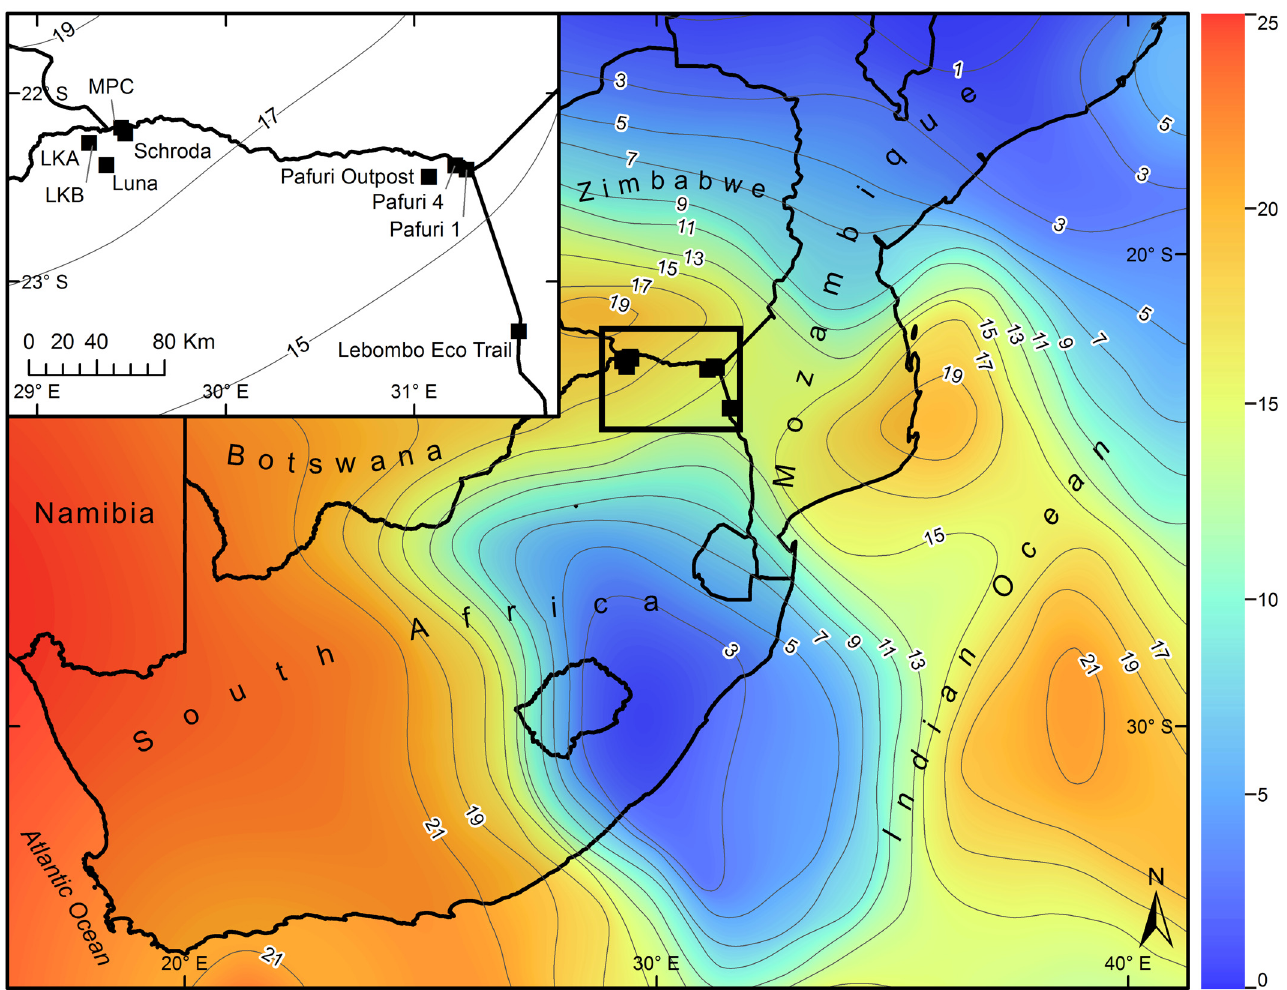
Fig 1. Map of the Mapungubwe baobab sample sites. The 5 baobab trees comprising the Mapungubwe sample came from approximately 200km west of the Pafuri baobab samples. The contour and color scale in the main map is an indication of the frequency of austral summer dry spells after. The color and contours are modified from [7] under a CC BY license, with permission from Inter Research Climate Research, original copyright 2004. The inset map indicates the relative proximity of individual trees to one another in the Mapungubwe and Pafuri records.